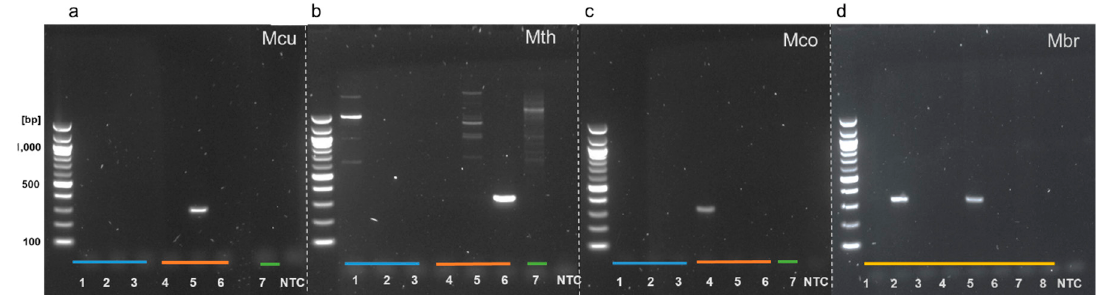
Figure 2. Agarose gel electrophoresis analysis of PCR products of reactions performed with F3 and B3 outer primers and selected bacterial, archaeal, and fungal DNA as templates. All the components in the PCR reactions were the same except for F3/B3 primers that were ( a ) Methanoculleus (Mcu), ( b ) Methanothermobacter (Mth), ( c ) Methanococcus (Mco), and ( d ) Methanobrevibacter (Mbr). Bacterial DNA templates (blue line) from Escherichia coli (lane 1), Staphylococcus epidermidis (lane 2), and Bacillus sp. 3PL (lane 3). Archaeal DNA templates (orange line) from Methanococcus maripaludis (lane 4), Methanoculleus marisnigri (lane 5), and Methanothermobacter thermoautotrophicus (lane 6), eukaryotic DNA was extracted from wheat root rhizobiome (green line, lane 7). For (d), eDNA from stool samples was used as a template (yellow line, lanes 1–8). A non ‐ template control (NTC) was included in all assays.